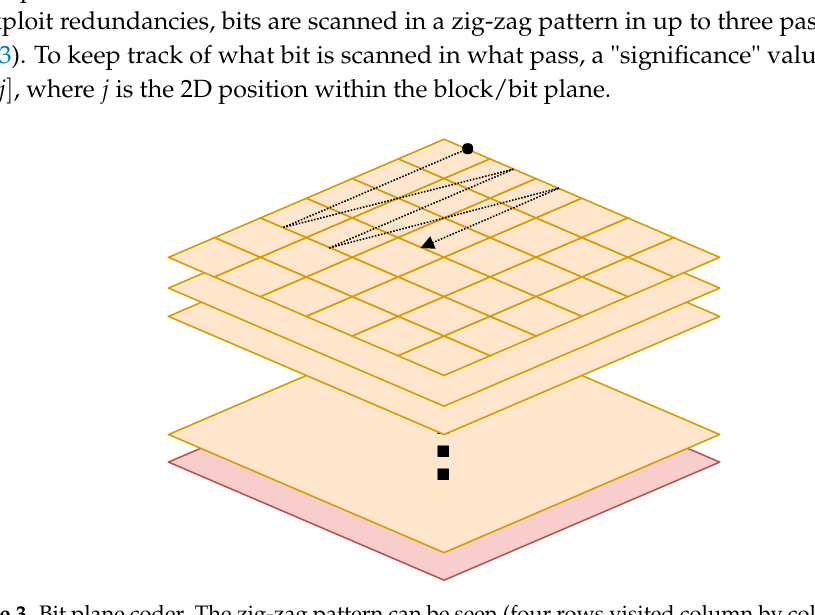
Figure 3. Bit plane coder. The zig-zag pattern can be seen (four rows visited column by column). This is repeated three times (three passes) until all bits from a plane have been visited. The sign bit plane (red) is coded